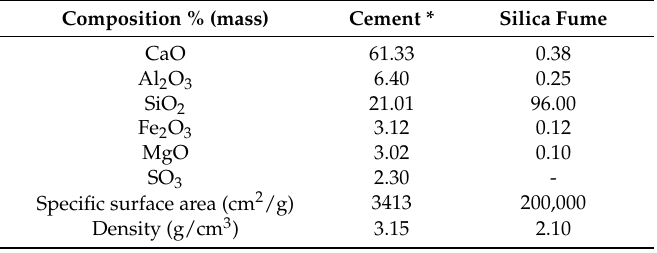
Table 2. Chemical compositions and physical properties of type 1 Portland cement and silica